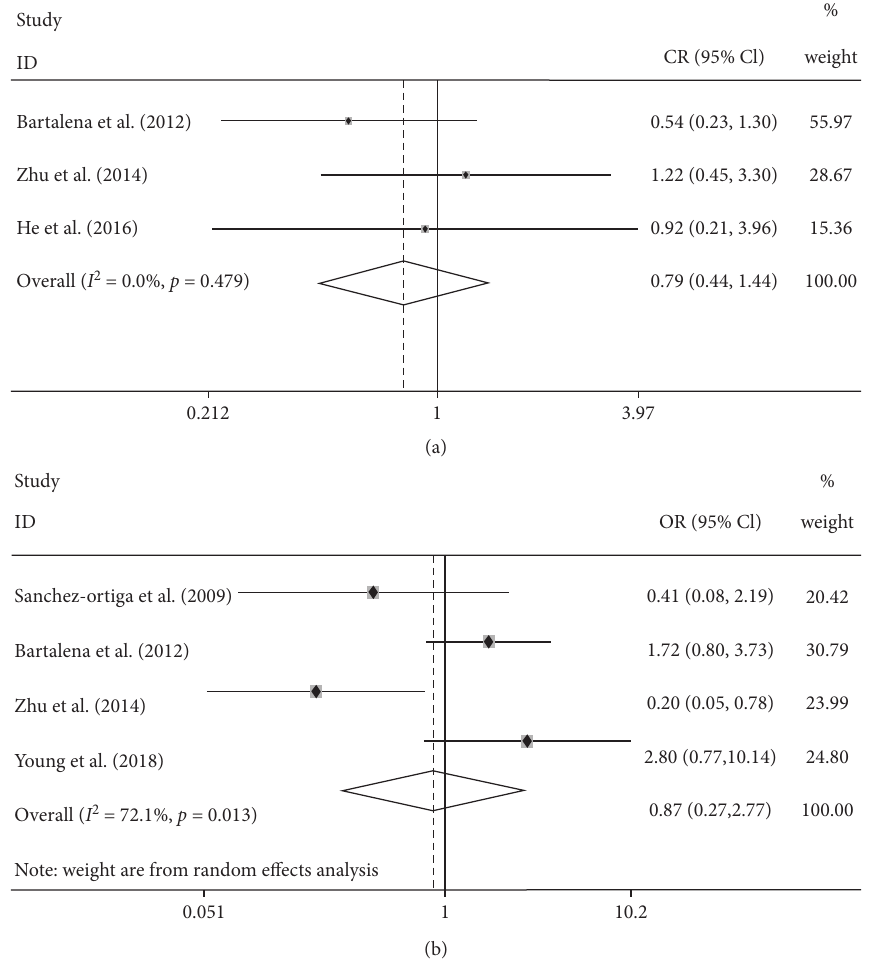
Figure 3: Forest plot of the rate of proptosis improvement (a) and retreatment rate (b), EUGOGO regimen vs. higher-dose regimen.